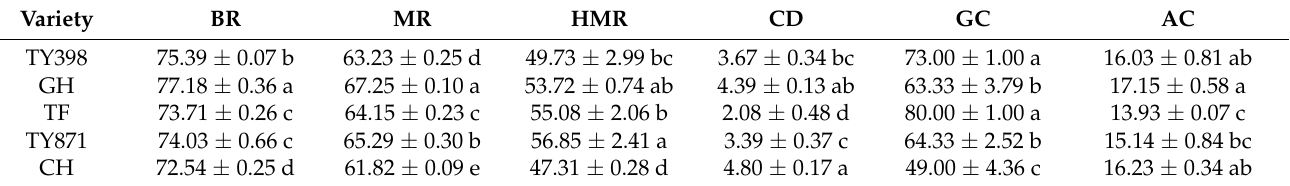
Table 2. Differences in rice quality of two hybrid rice varieties ( Oryza sativa L.) and their